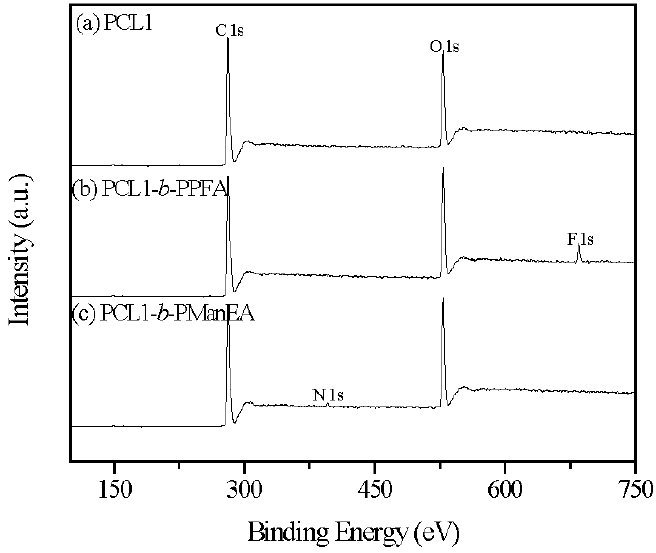
Figure 3. X-ray photoelectron spectroscopy (XPS) wide-scan spectra of: ( a ) PCL1 homopolymer; ( b ) PCL1- b -PPFA; and ( c ) PCL1- b -PManEA block copolymers.